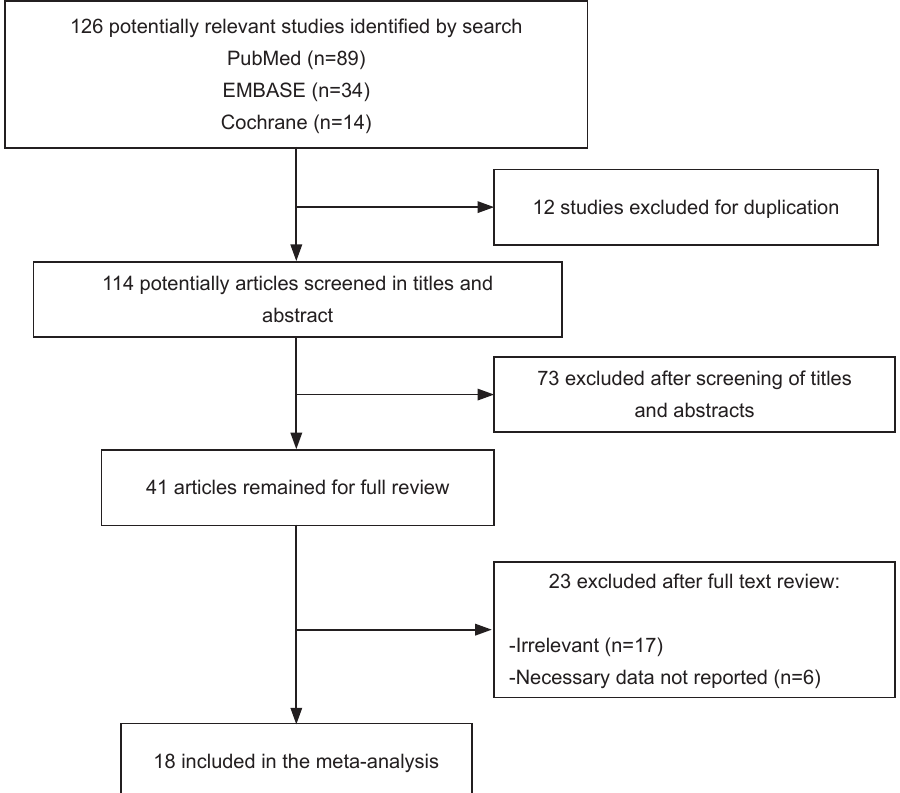
Figure 1 Flow diagram for identification of eligible studies